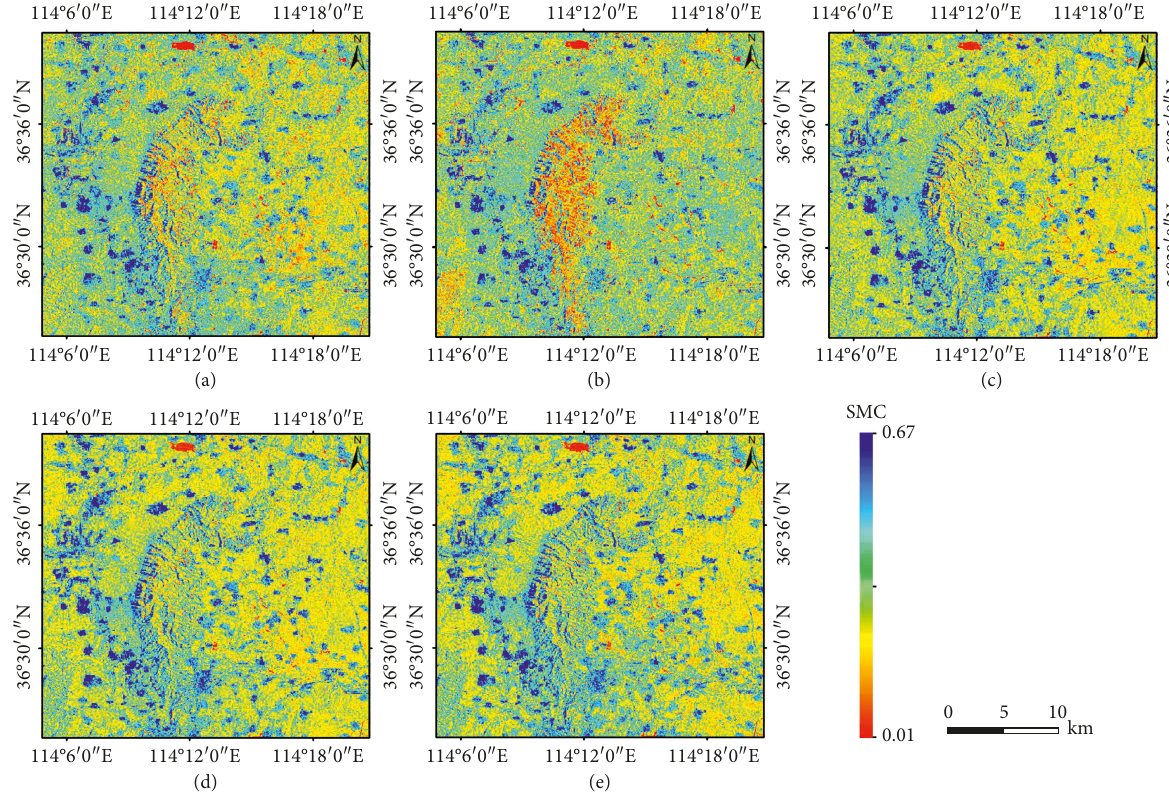
Figure 10: Soil moisture maps of the study area using the developed Alpha model. (a)–(e) represent the soil moisture maps obtained on